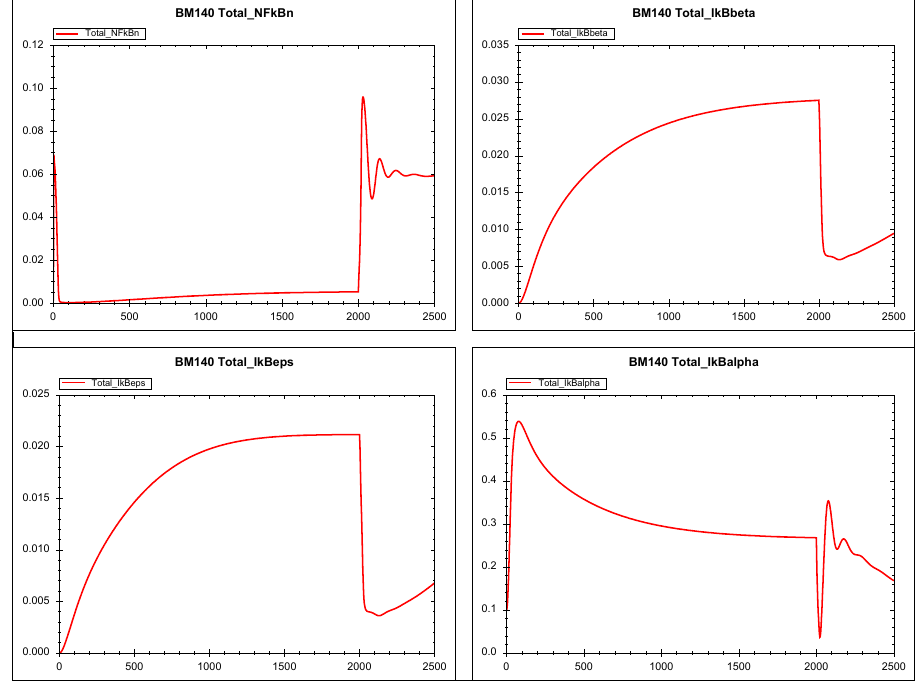
Figure C.3: The simulation result gained from the simulation description given in Listing C.3